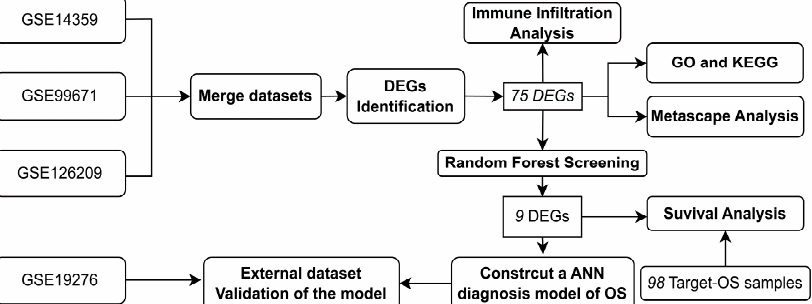
Figure 1. Simplified flow chart. This is the overall simplified flowchart of the whole study, which is divided into four main subsections: data collation related to diagnostic models, gene screening and analysis, diagnostic model building and validation, and diagnostic genes for prognostic correlation analysis.